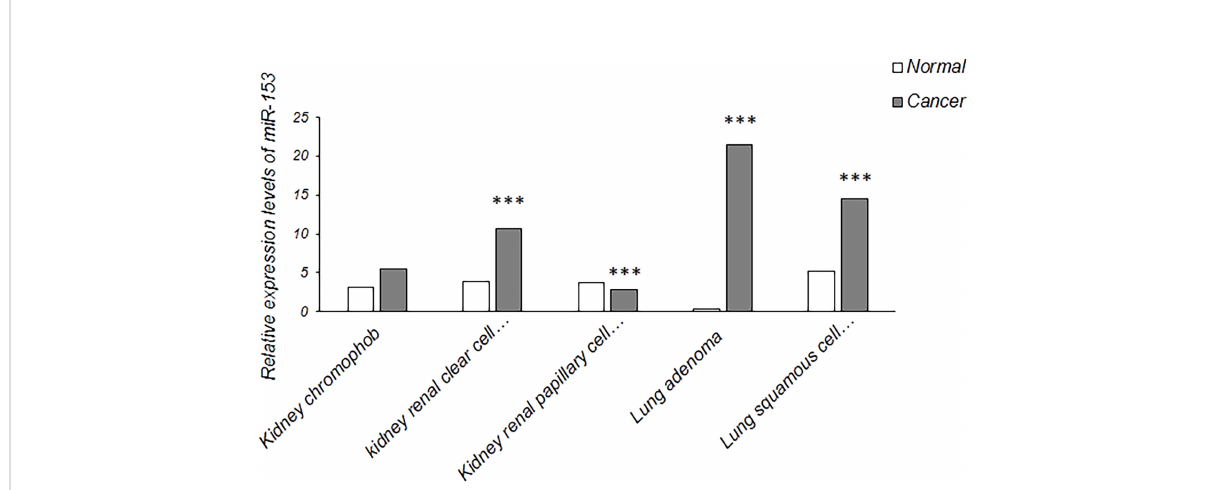
FIGURE 5 Relative expression levels of miR-153 in some cancers with diverse histological subtypes (The data were obtained from ENCORI). Kidney chromophob (N = 65) against normal samples (N = 24), kidney renal clear cell carcinoma (N = 517) against normal samples (N = 71), kidney renal papillary cell carcinoma (N = 289) against normal samples (N = 32), lung adenocarcinoma (N = 512) against normal samples (N = 20) and lung squamous cell carcinoma (N = 475) against normal samples (N = 38). N indicates the number of tissue samples. ***P <